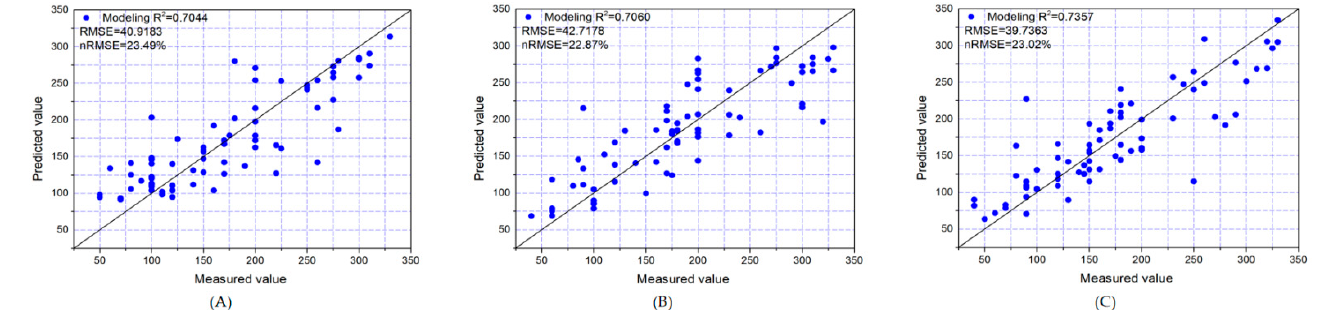
Figure 12. Models optimized with gradient vegetation features for winter wheat ( A ) variety 1, ( B ) variety 2, and ( C ) variety 3.